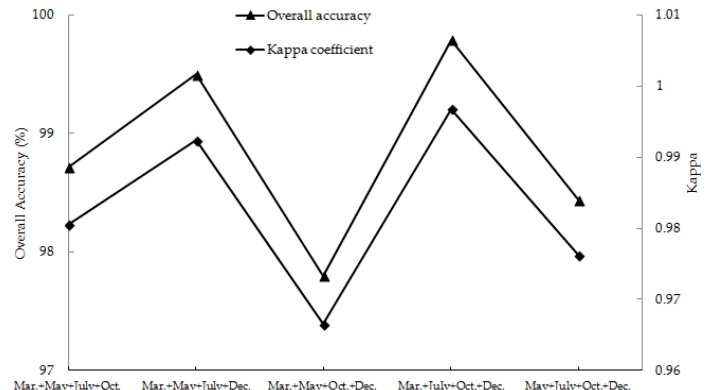
Figure 10. Overall classification accuracies and Kappa coefficients for land cover classification from five combined four-season images.